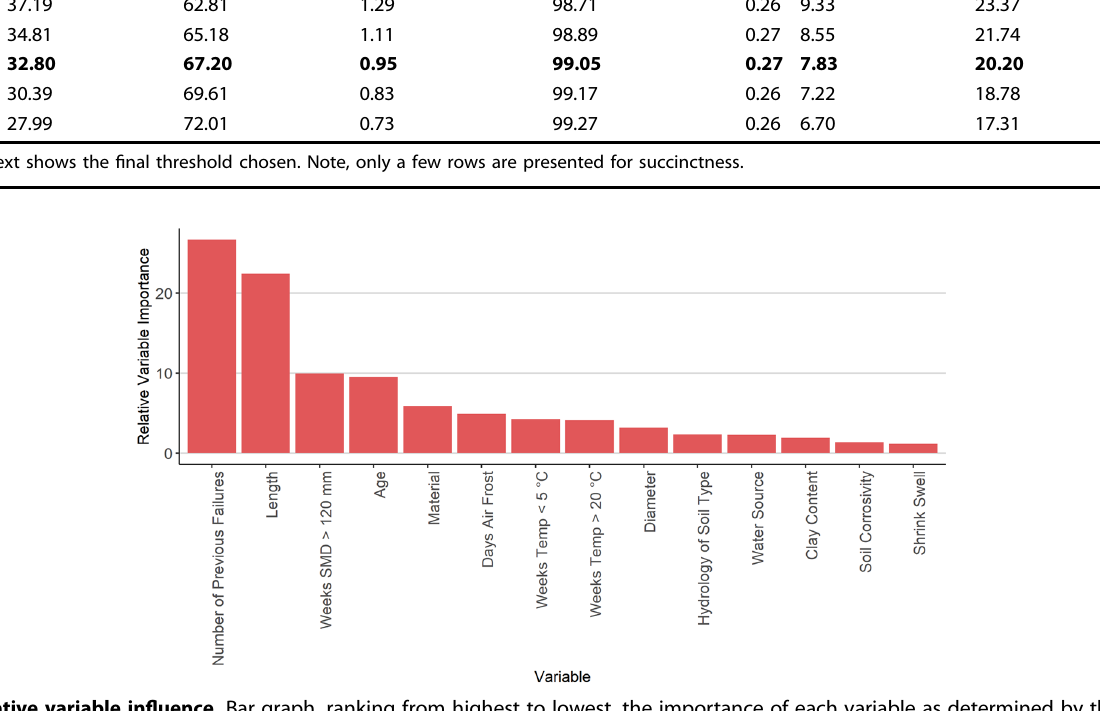
Fig. 3 Relative variable in fl uence. Bar graph, ranking from highest to lowest, the importance of each variable as determined by the model